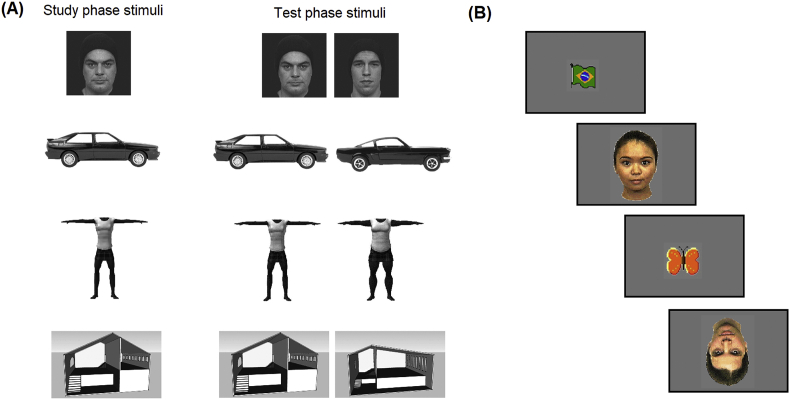
Stimuli used in the face recognition and face processing tasks in mid-childhood. Panel (A) shows examples of the face, car, body and scene stimuli used in the face recognition task in mid-childhood. Panel (B) shows examples of the upright and inverted face and fixation stimuli used in the EEG face processing task in mid-childhood.